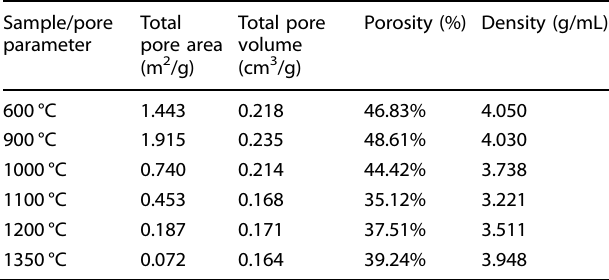
Table 2. Pore parameter of PCMM at various heat-treatment temperatures. Sample/pore